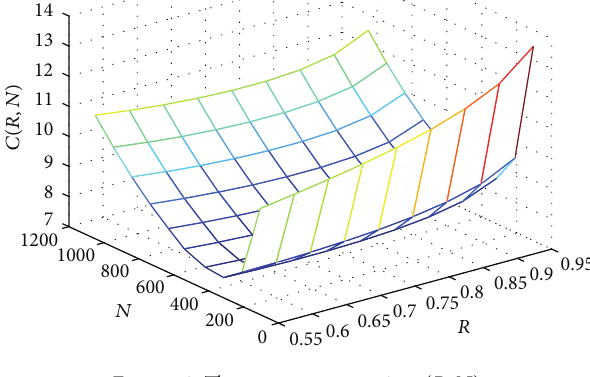
Figure 3: The average cost against (𝑅,𝑁)